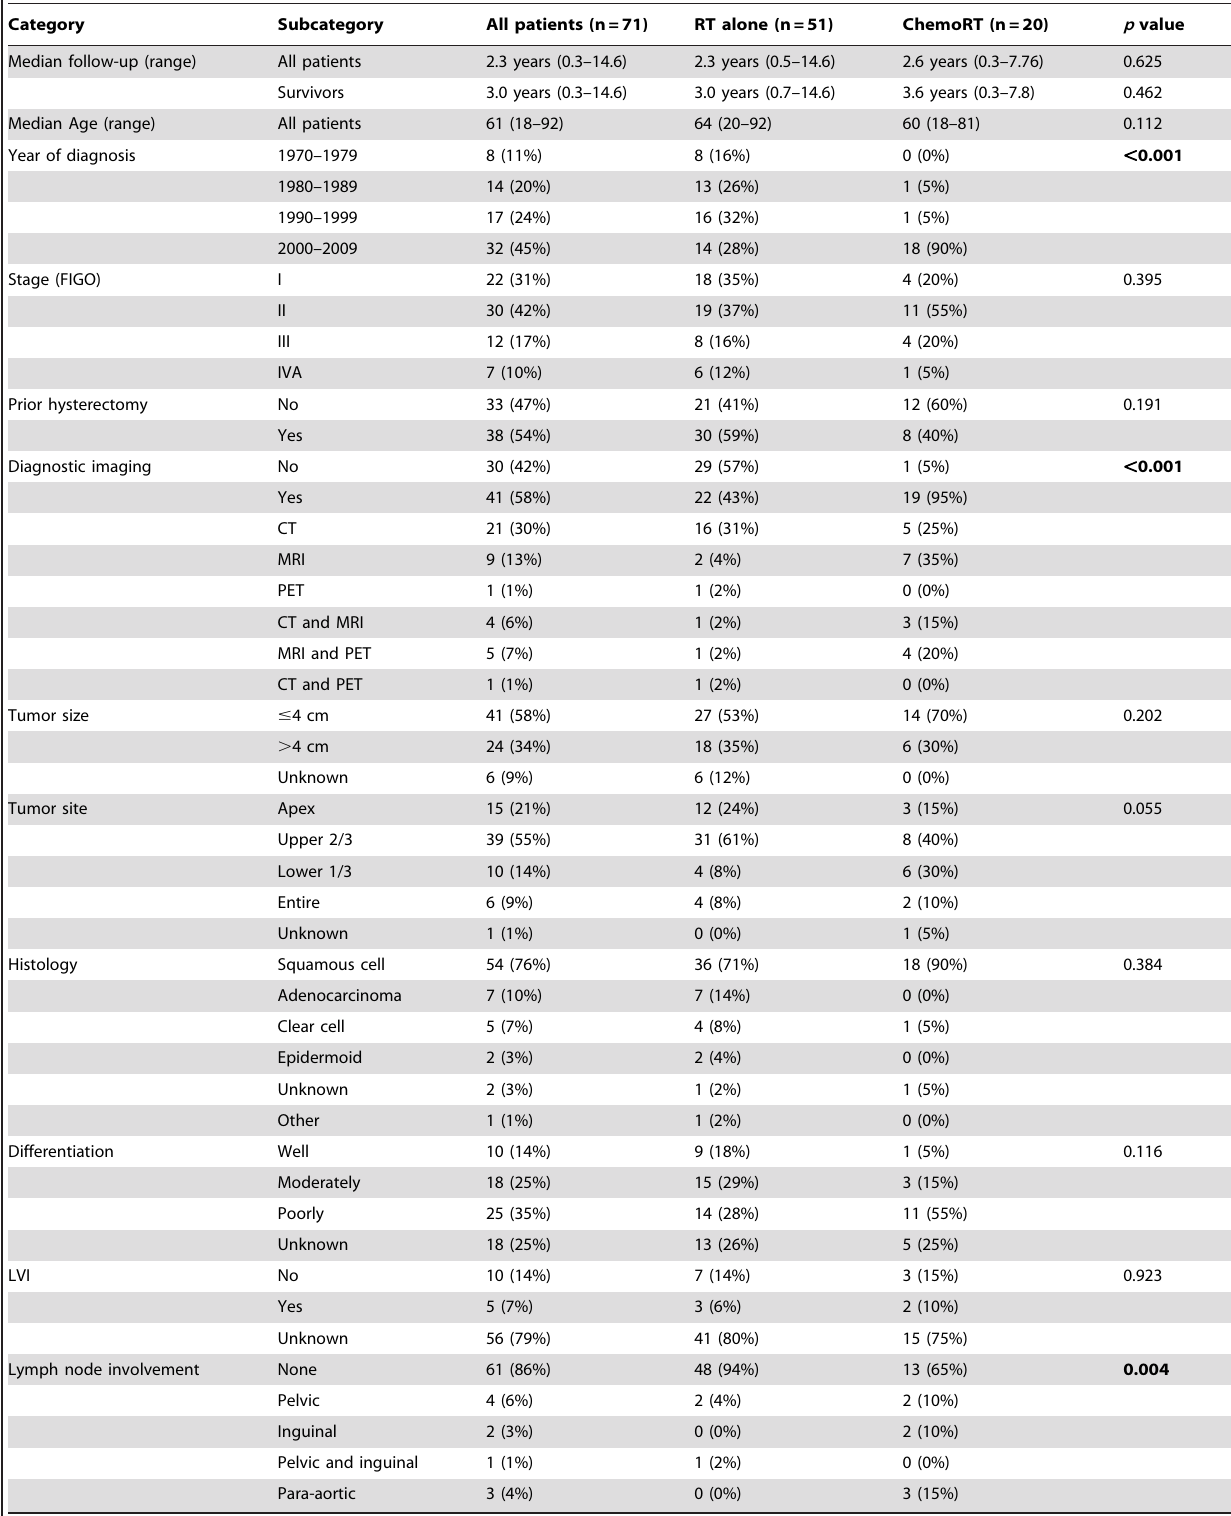
Table 1. Patient and tumor